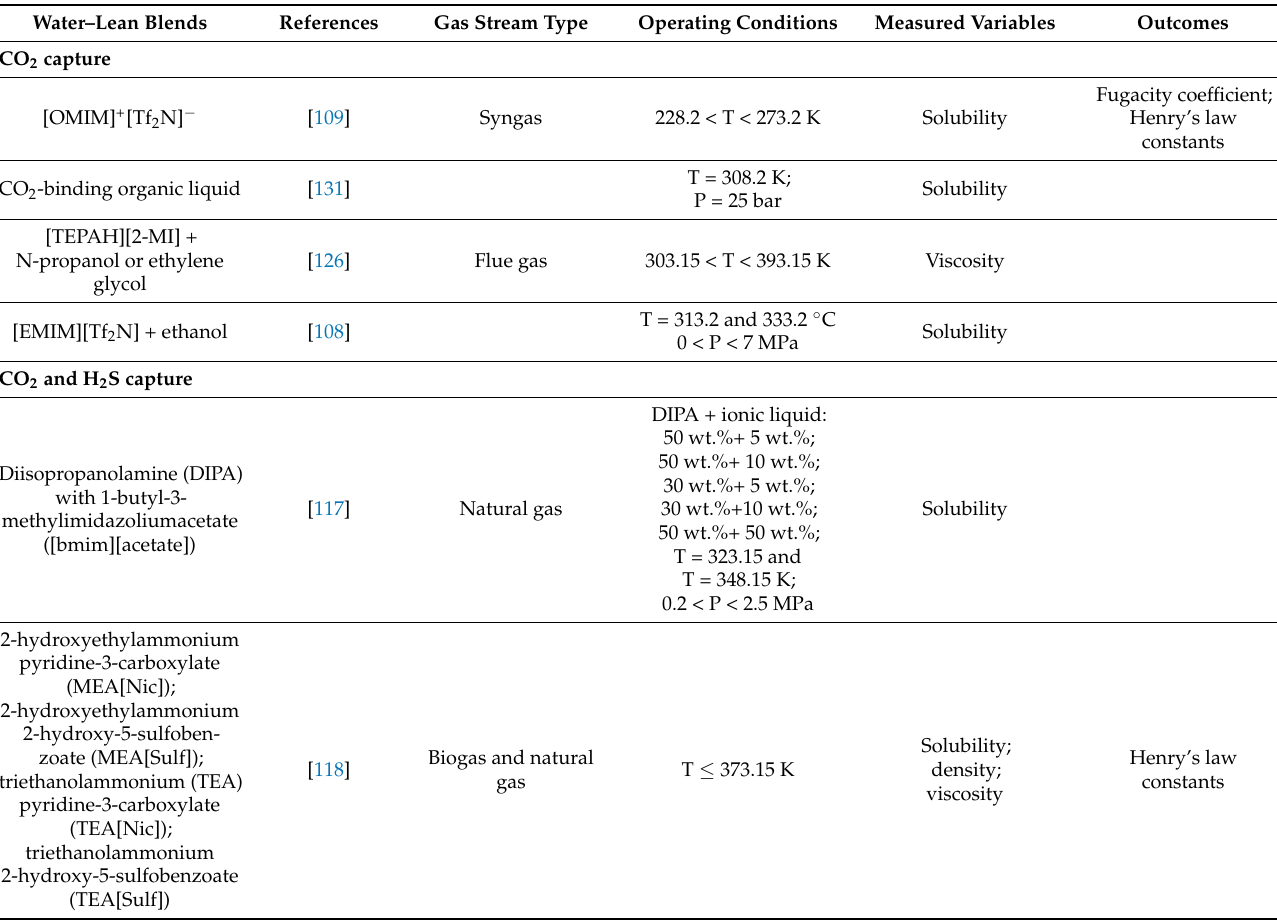
Table 5. Water–lean solvents studied in the literature with relative experimental operating conditions and provided